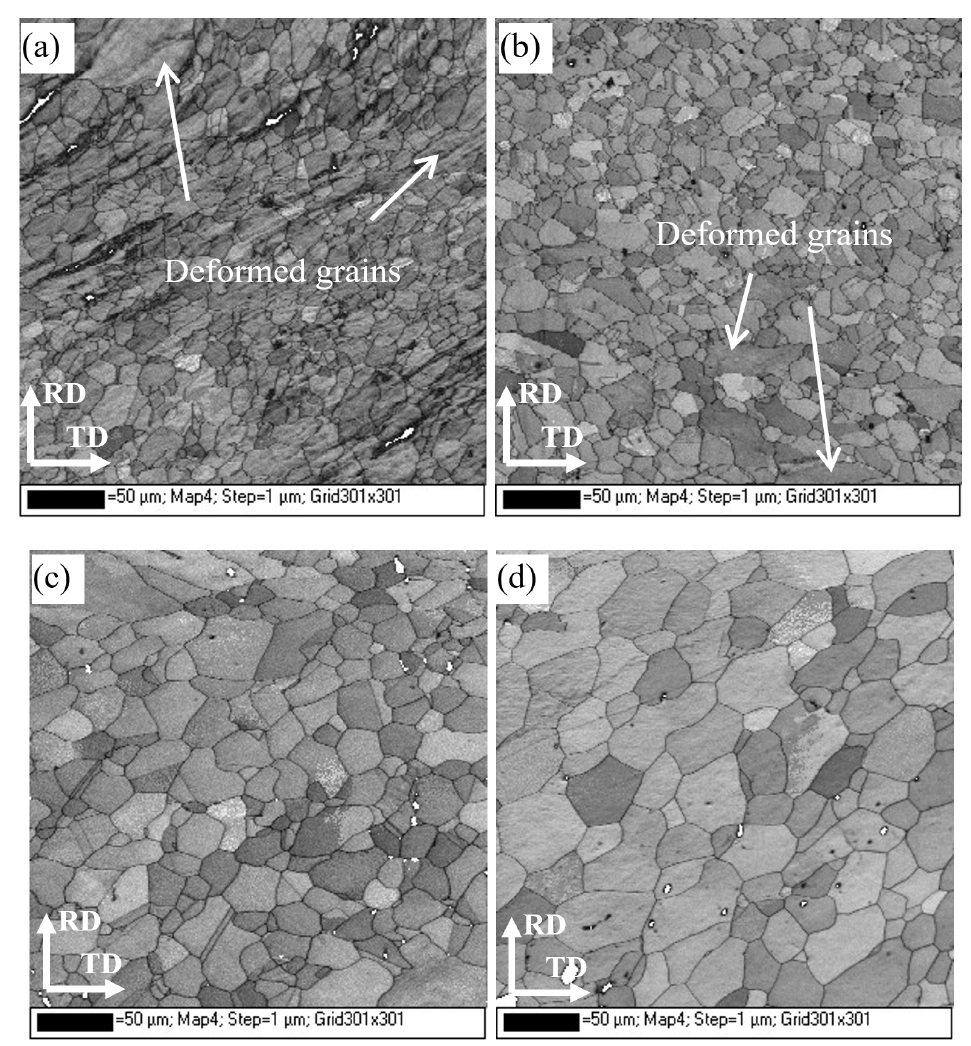
Figure 8. The band contrast maps of 4W deformed at 1050–1200 °C with a strain rate of 1 s − 1 ; ( a ) 1050 °C; ( b ) 1100 °C; ( c ) 1150 °C; ( d ) 1200 °C.